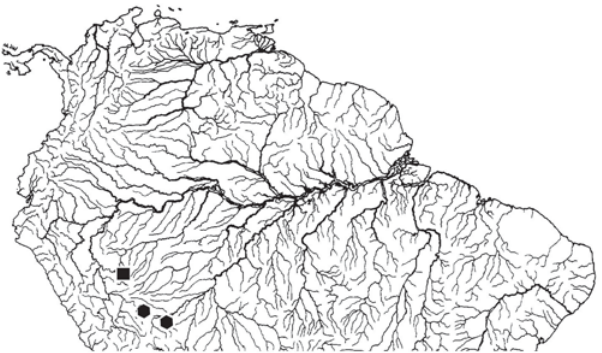
Fig. 3. Map of part of South America showing the known geographic distribution of Gymnotus chaviro . Type locality indicated by square symbol. Base map by M.